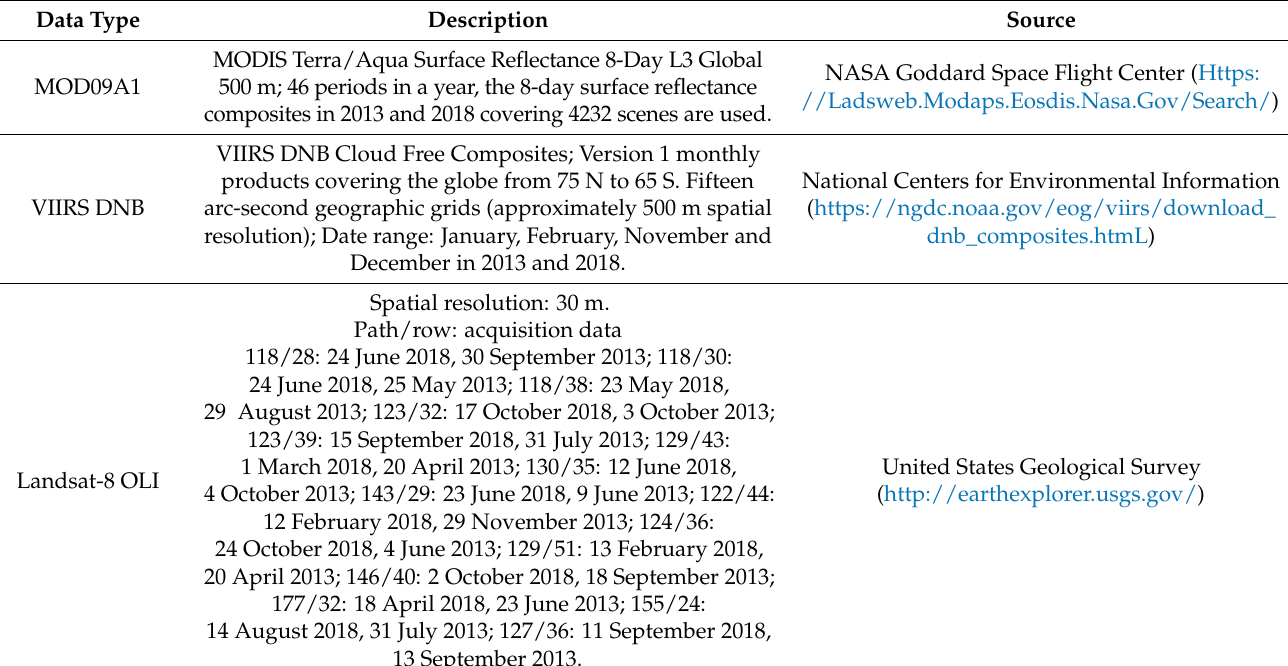
Table 1. Details of remote sensing